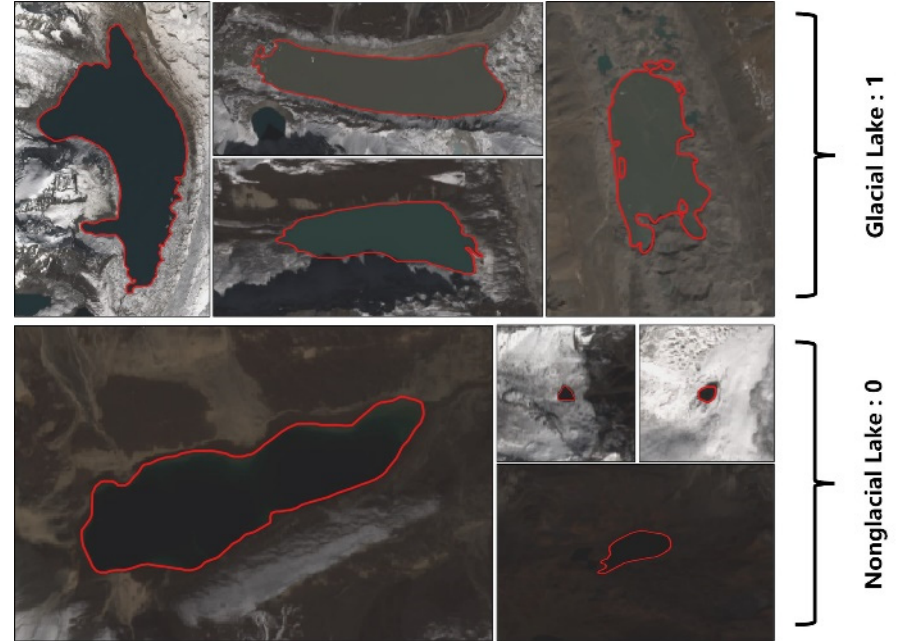
Figure 3. Examples of alpine lakes and corresponding labels used for classification.